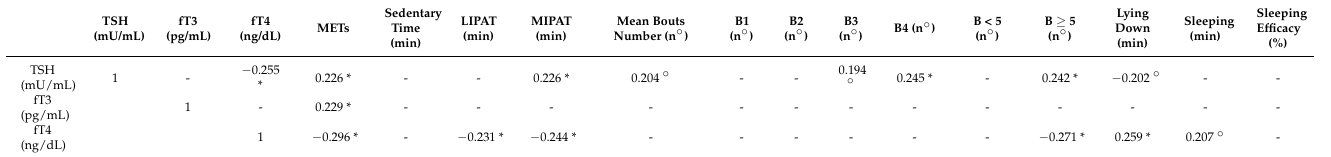
Table 4. Significant correlations of thyroid hormones with physical activity and sleeping parameters, adjusting for the effects of age, CRP and MMI in female